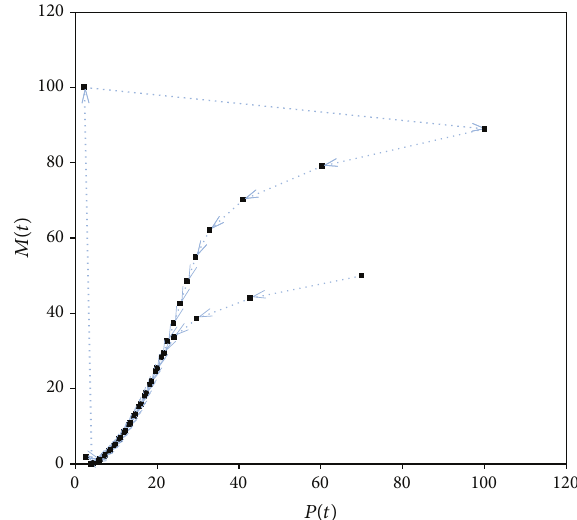
Figure 2: Experimental example. Here, 𝛼 = 0.7 , 𝛽 = 0.9 , 𝐾 = 10 , and ℎ = 1 . The initial point is 𝑃 0 = 70 and 𝑀 0 = 50 with 𝑁 = 100 and 𝑀 = 100 . Arrows show the directions of the migration of the system state. The system state moves toward the origin after leaving the initial point. Interestingly, however, there is a loop starting from near the origin. The presence of the loops implies a cycle in the system